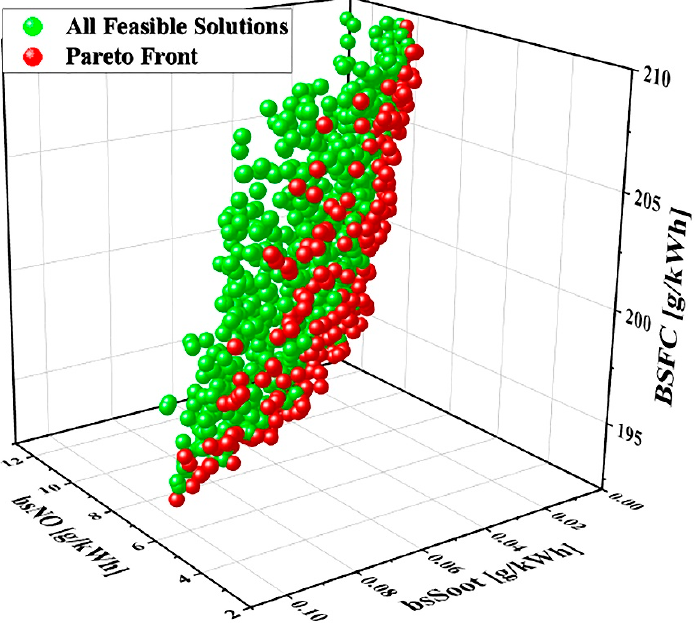
Figure 16. All feasible solutions and pareto frontier in the bsNO—bsSoot—BSFC objective space.